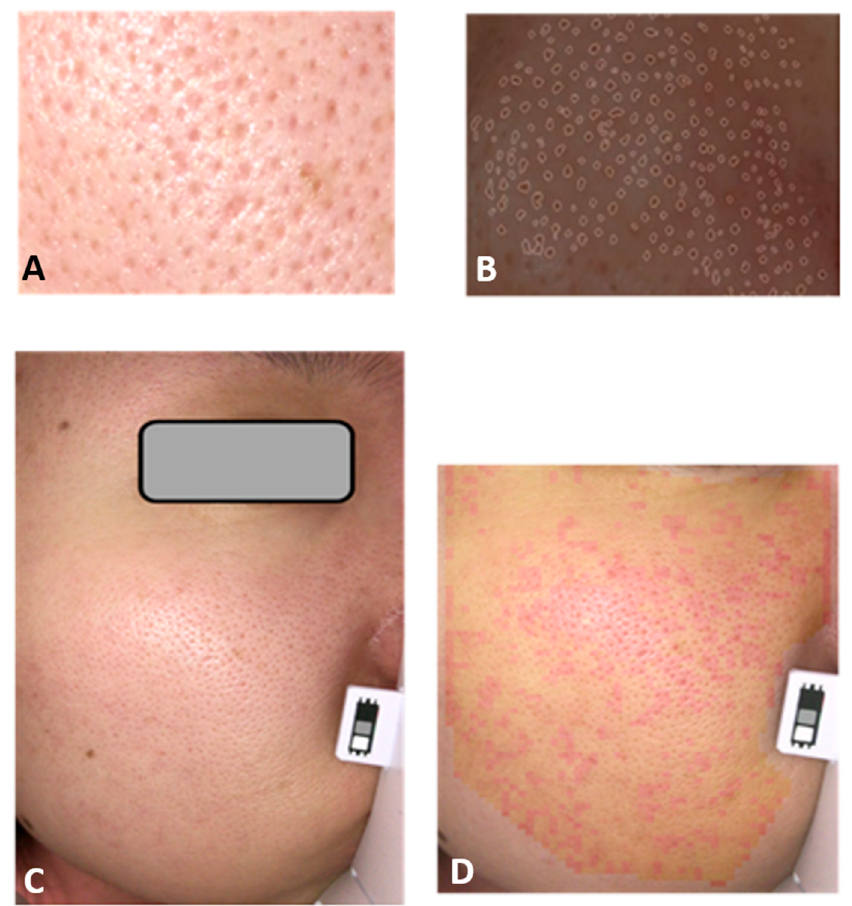
Figure 2. Calculation of pore area and redness variation. Facial pores at cheek ( A ) were analyzed by the image analysis algorithm to detect circular pore-like shapes via edge-enhanced binary images ( B ). Redness variation of cheek ( C ) was based on the variation and brightness of hemoglobin chromophore tone distribution by a Fourier transformation ( D